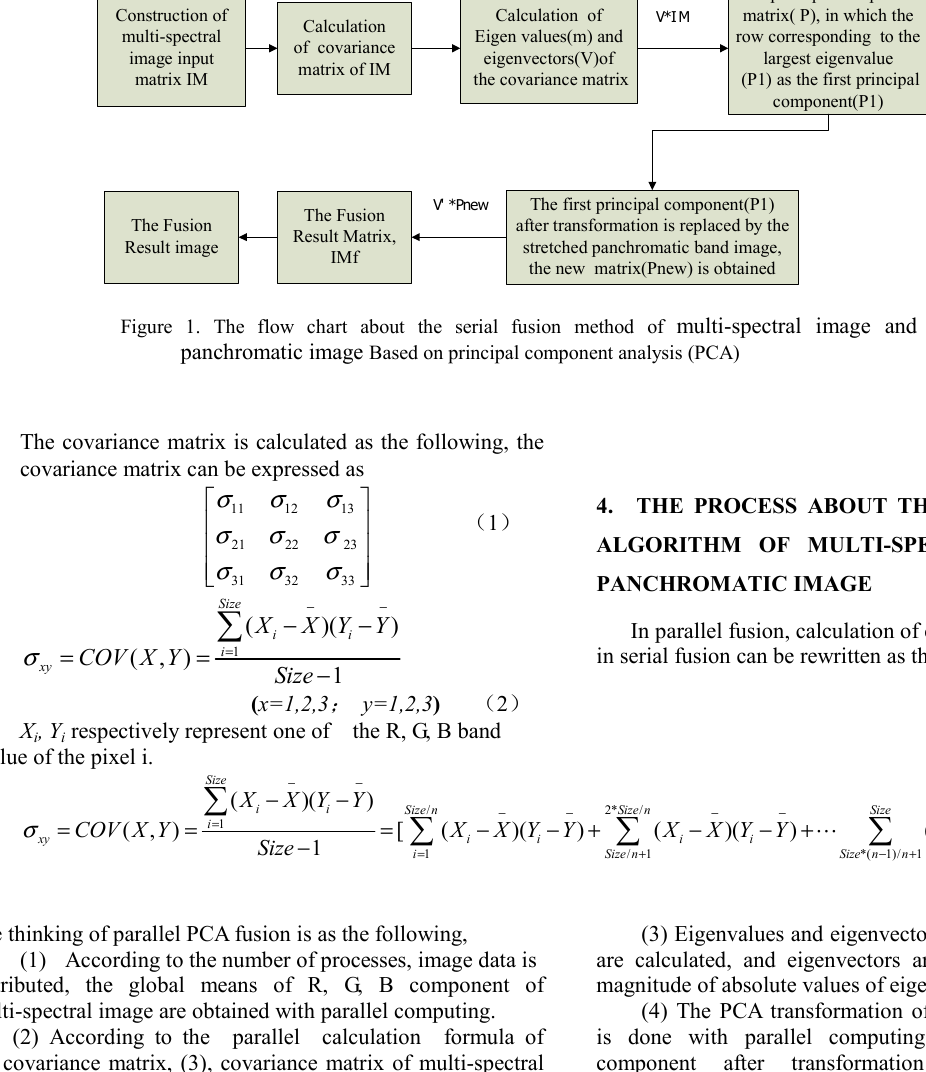
panchromatic band image.